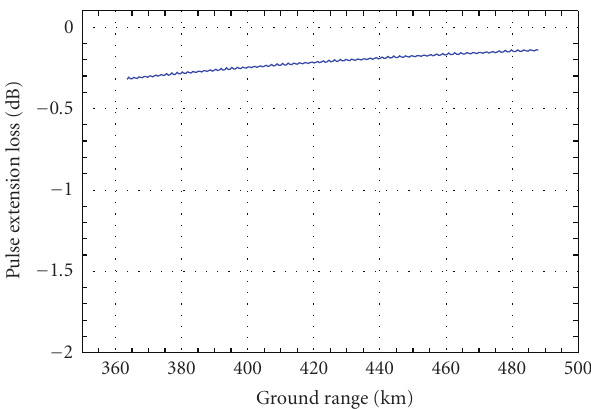
Figure 11: The pulse extension loss of the planar system versus ground range.